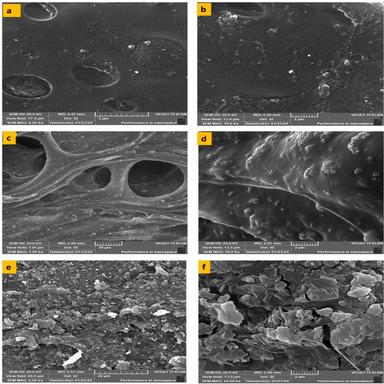
SEM images of a) PVA-chitosan- TiO2, c) PVA-chitosan- NiO, and e) PVA-chitosan- TiO2@ NiO films b,d,f) higher mafnification.